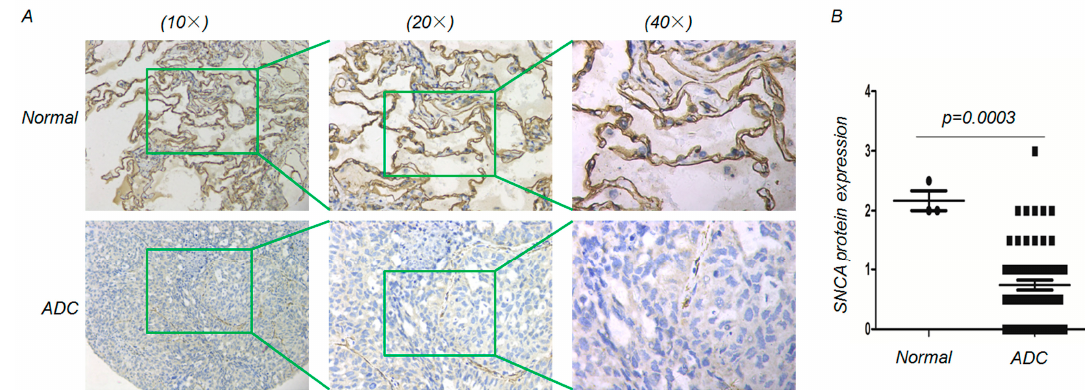
Figure 2. Downregulation of SNCA in ADC tissues array. ( A ) Immnunohistochemistry analysis (IHC) analysis was used to examine the level of SNCA expression in a commercial ADC tissue array. Representative images are shown. ( B ) The quartile graph indicate that the protein level of SNCA significantly downregulated in ADC patients.